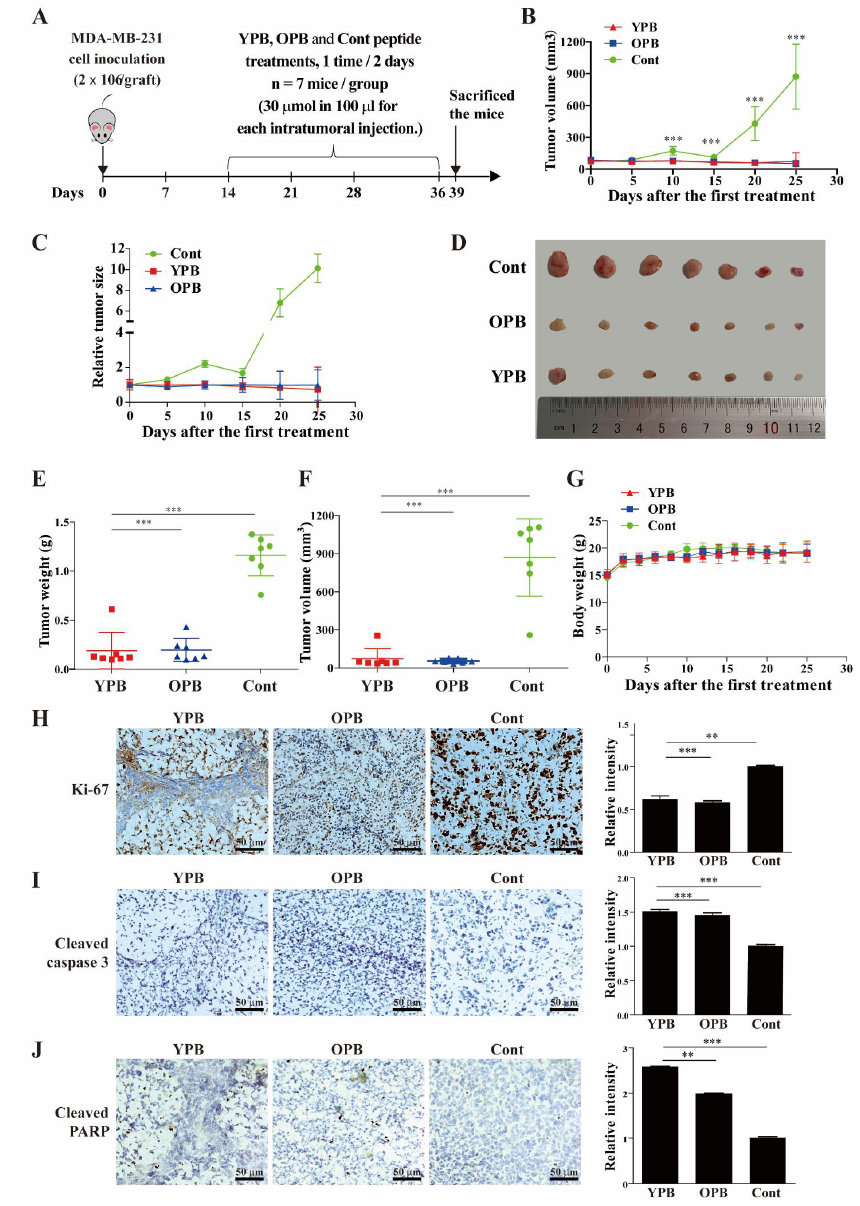
Figure 5. Effects of the peptides on breast cancer growth in a xenograft mouse model . ( A ) The experimental design of the mouse xenograft study. MB-MDA-231 cells (2 × 10 6 ) were subcutaneously inoculated at the right or left flank of each BALB/c nude mouse. After the tumors developed to a volume of approximate 60–100 mm 3 , the mice were randomly divided into 3 groups with 7 mice in each group. The YPB, OPB, and Cont peptides were intratumorally injected into the tumors of the mice in the three groups correspondingly with a dosage of 30 µ M in 100 µ L per injection and injected every other day for 22 days. The mice were sacrificed 3 days after the last injection. ( B , C ) Tumor volumes ( B ) and their relative sizes ( C ) from the mice in the 3 groups after the initial peptide injection. ( D ) Image of actual xenograft tumors excised from the mice treated by the peptides. ( E , F ) The weights and volumes of the excised tumors after the mice were sacrificed. ( G ) The body weights of the mice in the 3 groups after the initial peptide injections. ( H – J ) Immunohistochemical analyses of xenograft tumors. Representative images of immunohistochemical staining using antibodies against Ki-67 ( H ), cleaved caspase3 ( I ), and cleaved PARP ( J ) are presented in the left panels, and their quantification was shown in the right panels. The quantification was carried out under 400 × magnification in 3 randomly selected areas in each tumor, and the data shown are presented as mean ± SD of 3–5 tumor samples from individual mice in each group. Values represent the mean ± S.D., ** p < 0.01, *** p <